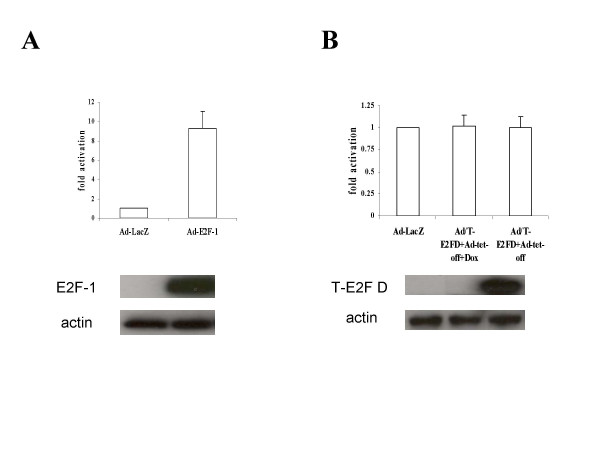
A. E2F-1 expression up-regulates the activity of the PUMA promoter in SK-MEL-2 cells. SK-MEL-2 cells were co-transfected with a total of 0.88 μg of DNA, including 0.8 μg of PUMA promoter reporter plasmid and 0.08 μg phRL-CMV plasmid (as an internal control) in a 12-well plate by using Lipofectamine 2000 transfection reagent. After 6 hours of transfection, the cells were infected with Ad-LacZ (as control) and Ad-E2F-1. Luciferase activity was examined 16 hours later as described in the manufacturer's protocol using the Dual Luciferase Reporter Assay System (Promega). The bar graphs depict the fold of activation in the luciferase assay after normalization for Renilla luciferase readout values. Each of the experiments is a representation of at least three independent experiments performed in duplicate. B. Transactivation domain of E2F-1 was required for the up-regulation of the PUMA promoter in SK-MEL-2 cells. SK-MEL-2 cells were co-transfected as in Fig. 2A. After 6 hours of transfection, the cells were infected with Ad/T-E2FD (expressing truncated E2F-1) at MOI 100 plus AdTet-off at MOI 5 (using as a helper virus), Ad/T-E2FD at MOI 100 plus AdTet-off at MOI 5, and doxycycline 1 μg/ml or Ad-LacZ at MOI 100. Luciferase activity was examined 16 hours later as in Fig. 2A. The bar graphs depict the fold of activation in the luciferase assay after normalization for Renilla luciferase readout values. Each of the experiments is a representation of at least three independent experiments performed in duplicate.